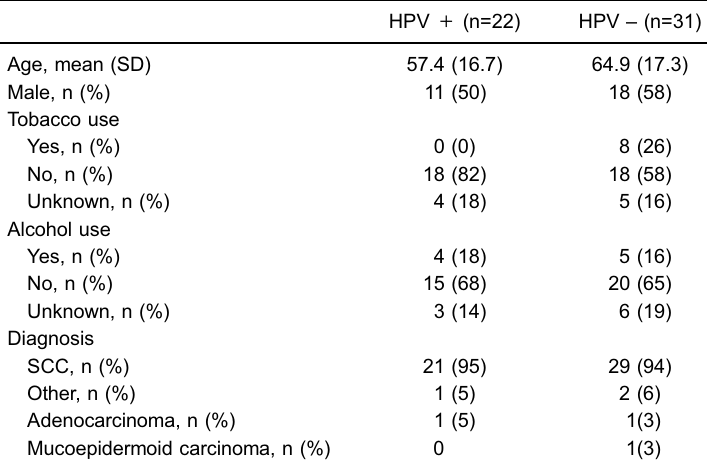
Table 1. Demographics and clinical characteristics of SOLCA-Guayaquil tongue cancer cohort (2006-2011)